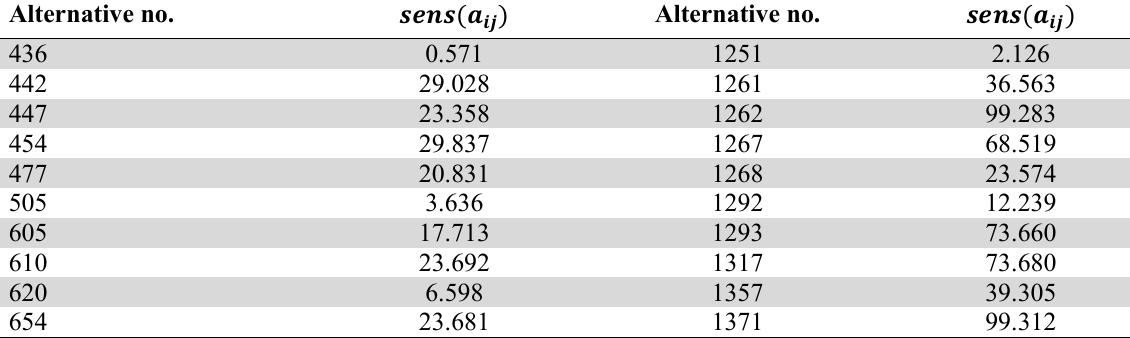
Sensitivity coefficients of some alternatives Alternative